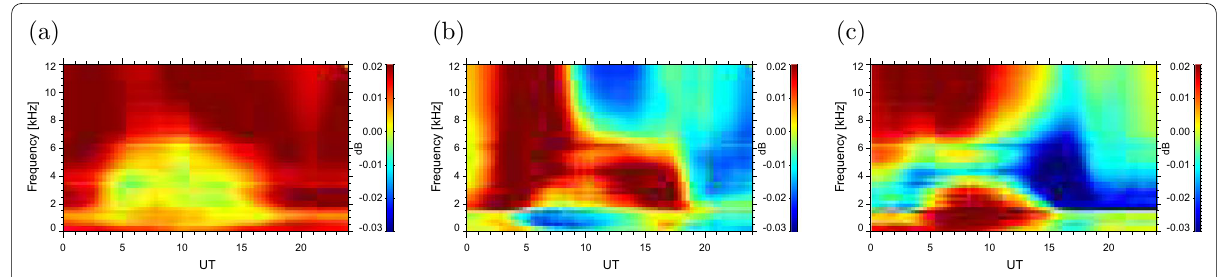
Fig. 1 First three principal component basis vectors obtained from Kannuslehto daily frequency–time